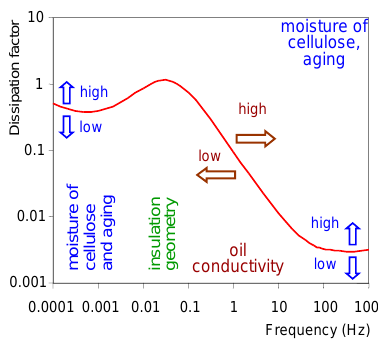
Figure 20. Interpretation of the dissipation factor vs. frequency of an oil-paper-insulation system [50].